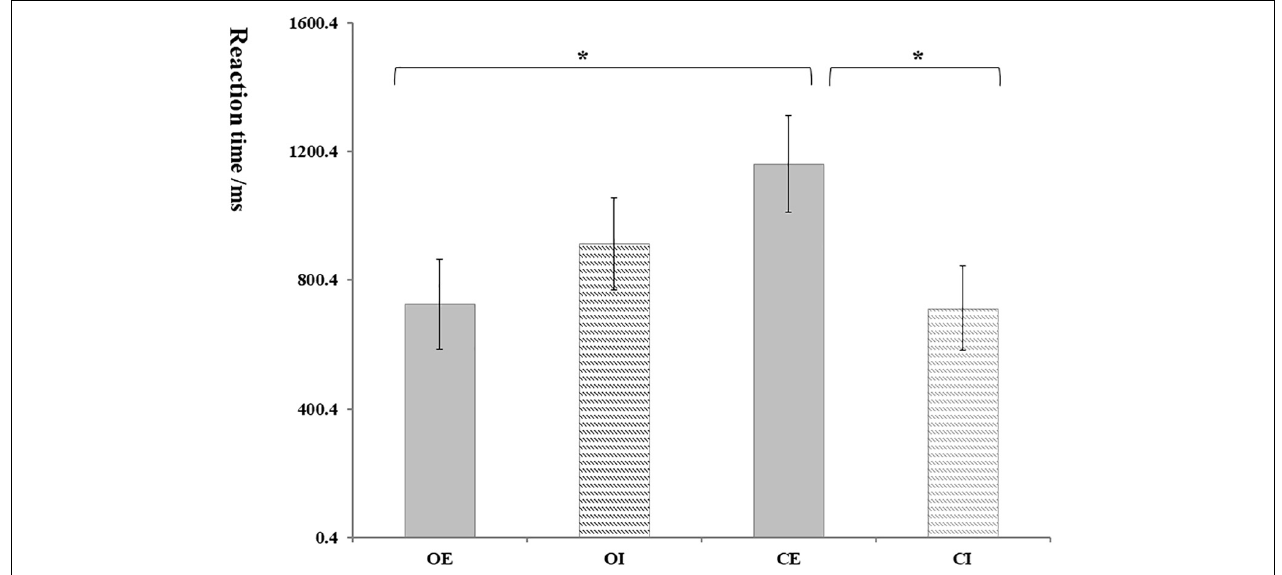
FIGURE 2 | The rate of trust. OE, orphans and exclusion group; OI, orphans and inclusion group; CE, controls and exclusion group; CI, controls and inclusion group. Error bars represent the standard errors. ∗ p < 0.05.